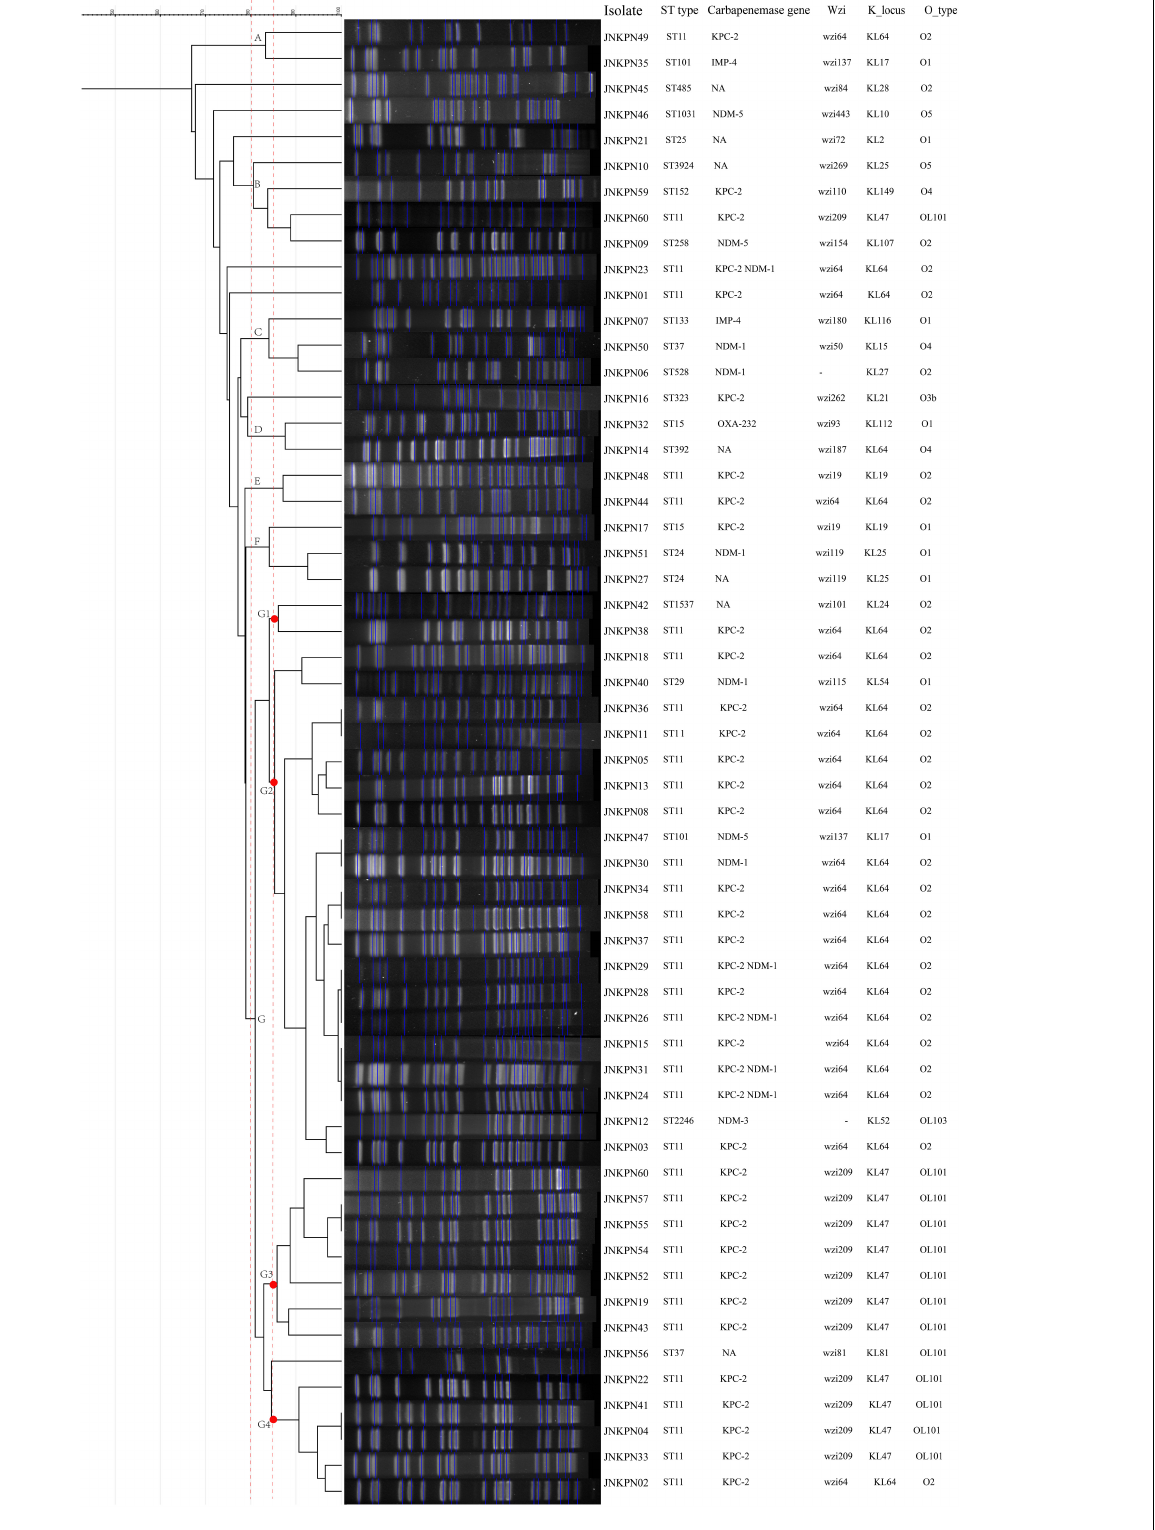
Frontiers in Microbiology |